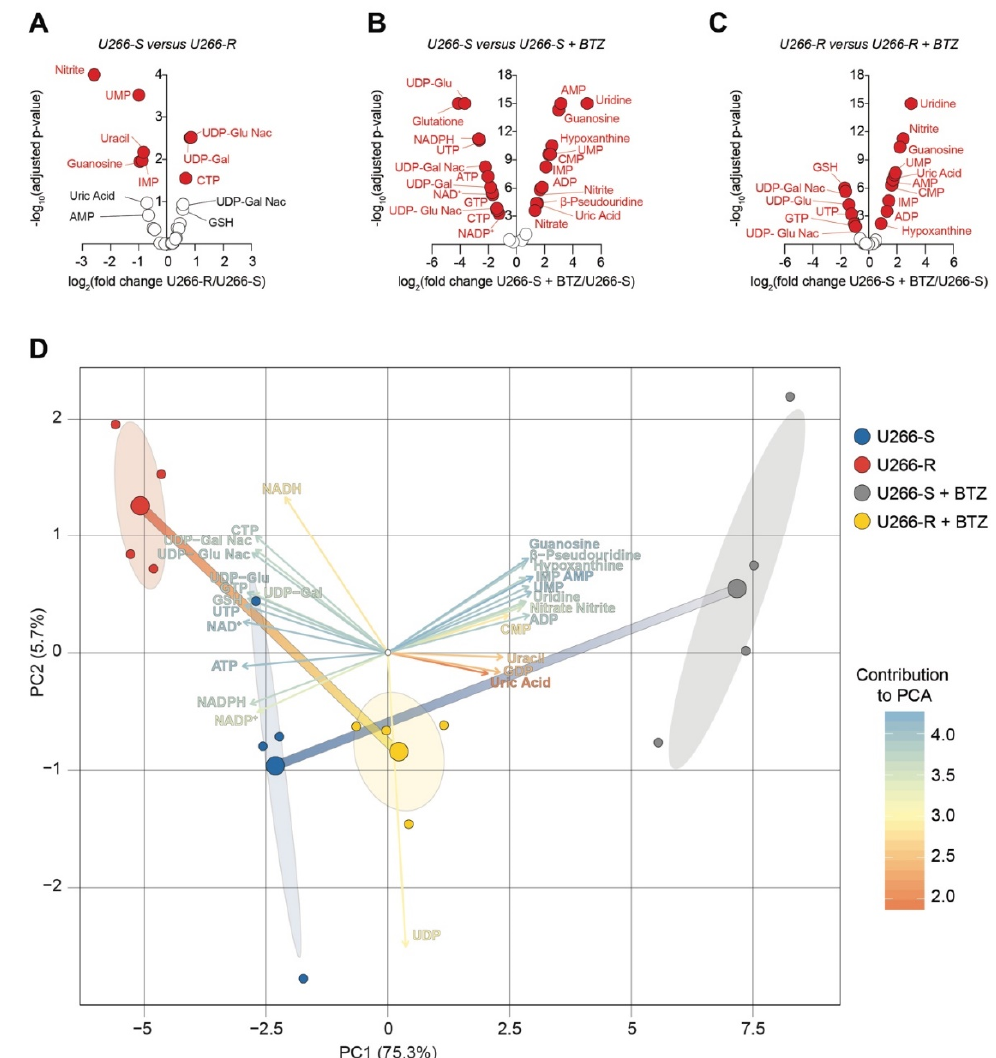
Figure 8. Principal component analysis on BTZ’s effects on metabolites levels in U266-S versus U266-R cells. ( A – C ) Volcano plots of metabolites showing −log10 of the adjusted p -value plotted against the log2 of the fold-change in metabolite levels in U266-R ( A ), U266-S + BTZ ( B ) and U266-R + BTZ ( C ) for n = 4 biological replicates. ( D ) Principal component analysis (PCA) biplot of metabolite levels for U266-S, U266-R, U266-S + BTZ and U266-R + BTZ ( n = 4); key colored arrows represent the variables’ contribution to the PCA; dots indicate individual replicates and bigger dots, the mean points of groups. Confidence ellipses for clusterized groups are also shown.